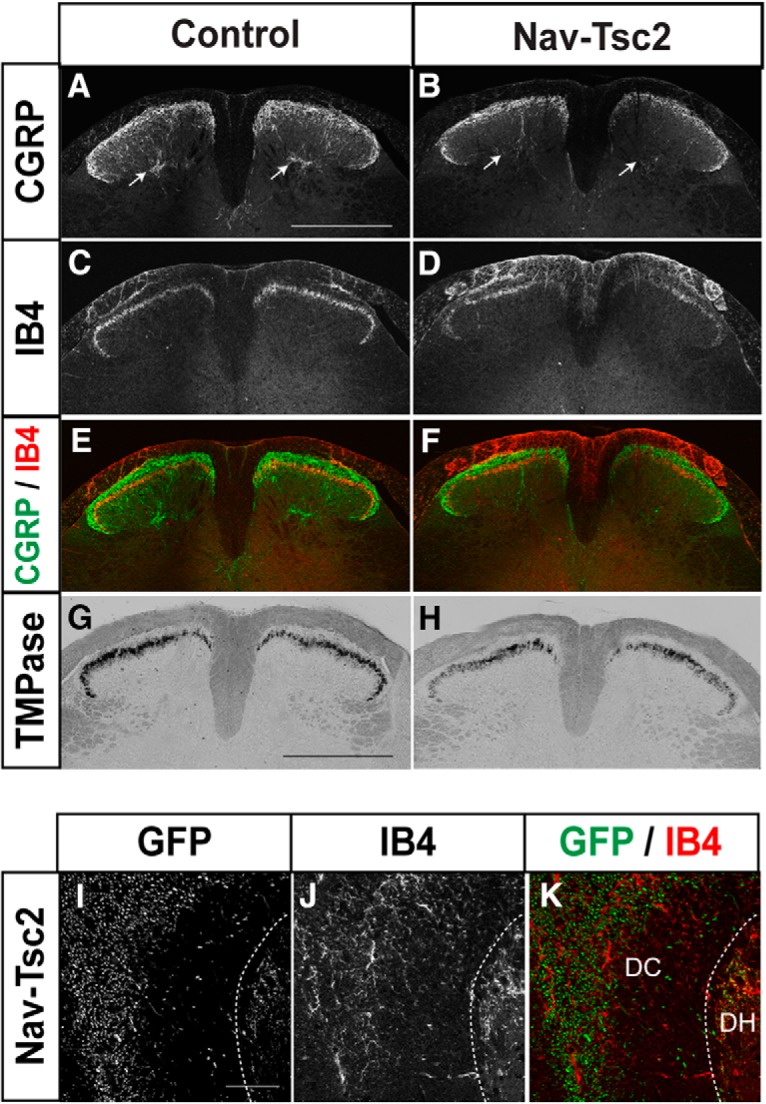
Laminar targeting of peptidergic and nonpeptidergic fibers is normal in dorsal horn of Nav-Tsc2 mice. A–F, Control and Nav-Tsc2 lumbar spinal cord transverse sections labeled with CGRP (A, B) or IB4 (C, D) as well as merged images (E, F). Note ectopic binding of IB4 in dorsal white matter of Nav-Tsc2 mice (D, F). Arrows show deep lamina innervation by CGRP. Scale bar: 500 µm; N = 7. G, H, TMP histochemistry of control and Nav-Tsc2 lumbar spinal cord transverse sections. Scale bar: 500 µm; N = 11. I–K, High-magnification confocal micrographs of lumbar spinal cord transverse sections from Nav-Tsc2; Rosa-GFP mice imaged for GFP fluorescence and IB4 labeling. Note lack of colocalization in the dorsal column (DC) white matter compared to dorsal horn (DH) gray matter. Scale bar: 50 µm; N = 5.